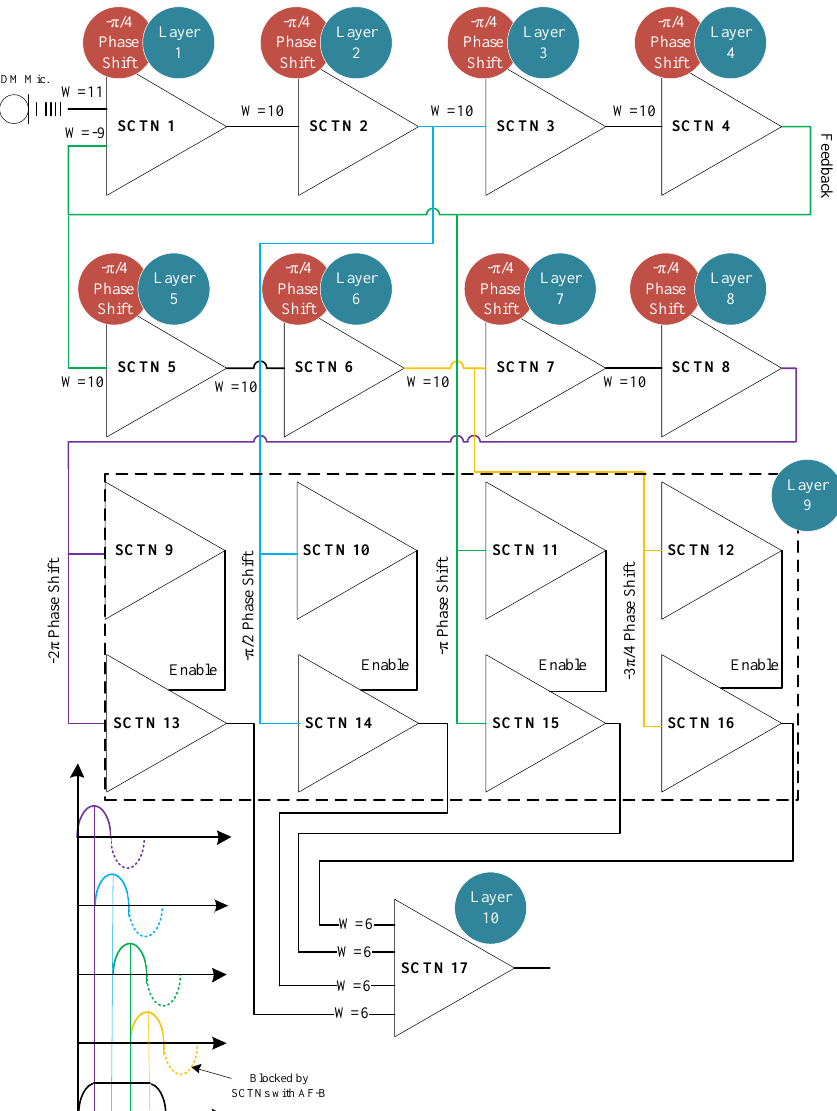
Figure 4. The proposed 10-layer resonator